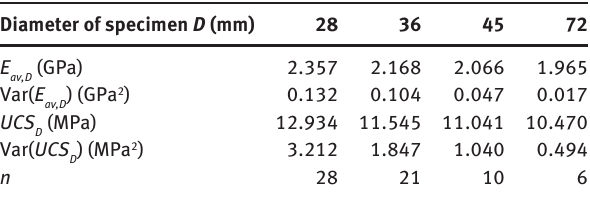
Figure 18: UCS as a function of the specimen diameter D .